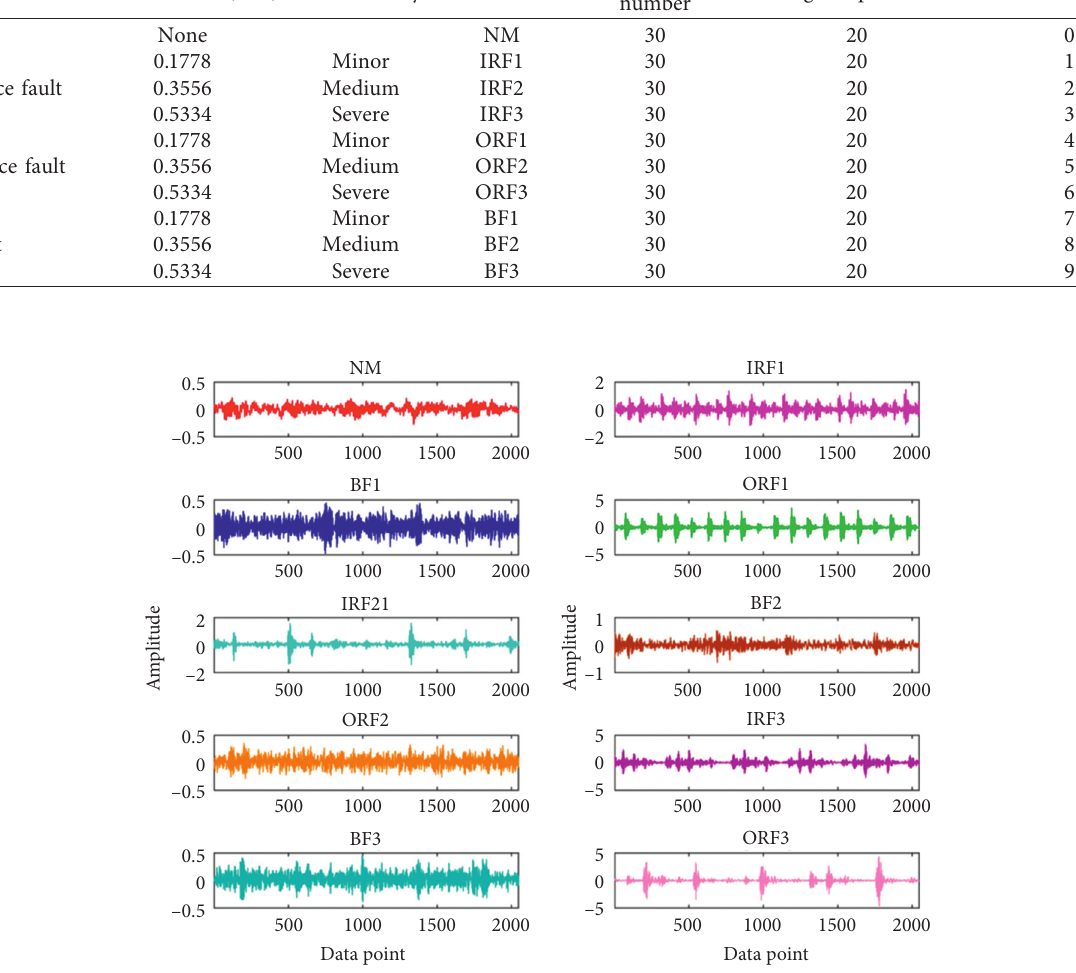
Figure 9: The time-domain waveforms of bearings with different types and fault